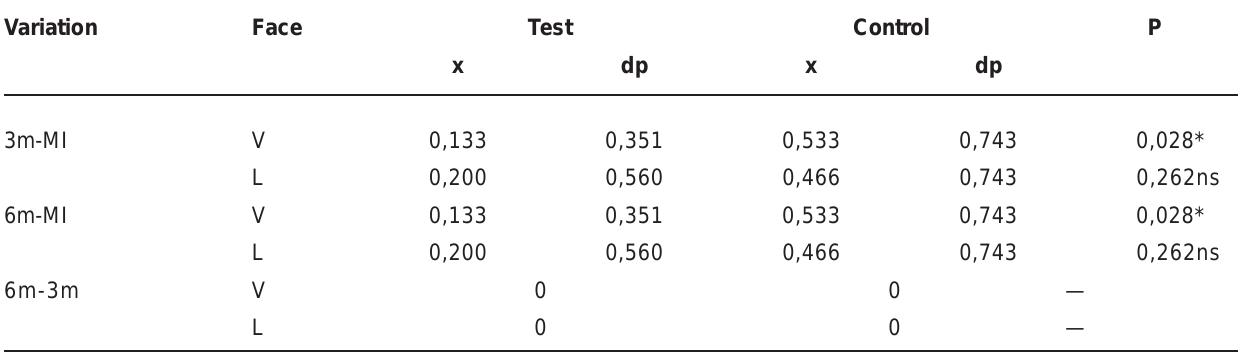
* significant statistically difference (P<0,05); ns No significant